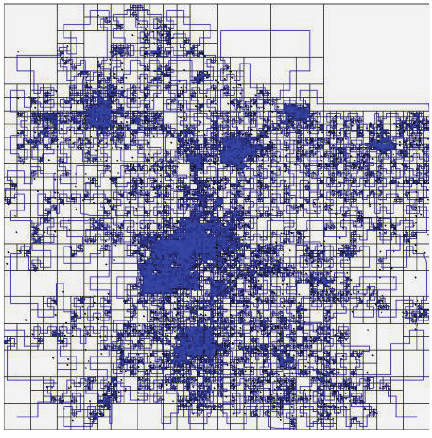
Figure 9: SHC over TG ( 𝑁 = 6 ). Figure 10: DSC over TG ( 𝐶 = 1